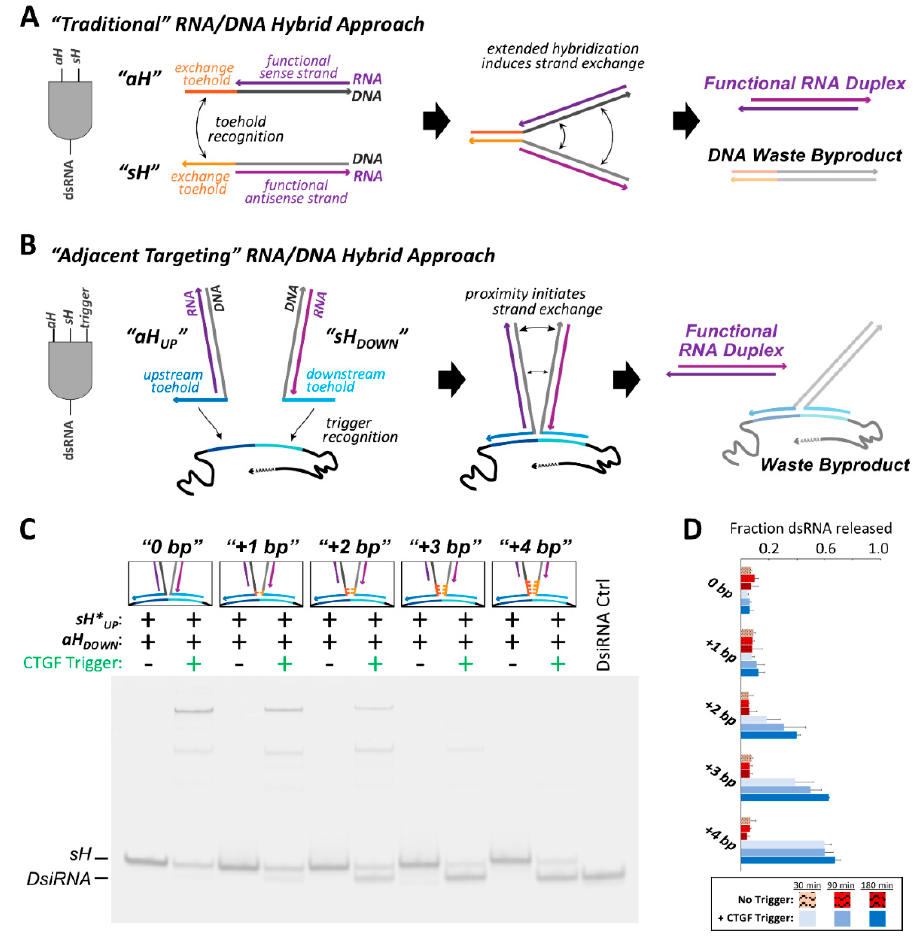
Figure 2. An RNA/DNA cognate pair system was designed to undergo conditional strand exchange by hybridizing to neighboring sites on an RNA trigger. ( A ) “Traditional” RNA/DNA hybrid pairs act as an 2-input AND gate. Hybridization between the single stranded toeholds of a sense hybrid ( sH ) and antisense hybrid ( aH ) initiates a thermodynamically driven strand exchange that generates a dsRNA duplex and DNA waste byproduct. ( B ) The “adjacent targeting” RNA/DNA hybrid system functions as a 3-input AND gate, requiring a hybrid pair as well as a specific RNA trigger sequence. The hybrid pair’s respective toeholds bind to regions of the trigger that are immediately upstream and downstream from one another. Anchoring the cognate hybrids in close proximity leads to initiation of the thermodynamically favorable strand exchange reaction and dsRNA release. ( C ) Five different cognate pairs of adjacent targeting hybrids were analyzed by 12% acrylamide non-denaturing PAGE for their ability to release a DsiRNA product. Each sense hybrid and the DsiRNA control assembly contained a 3 ′ 6-carboxyfluorescein (6-FAM) labeled sense RNA strand for visualization. The pairs of constructs differ in the number of DNA nucleotides inserted between the single-strand toehold and the RNA/DNA hybrid duplex. These inserted nucleotides were complementary between cognate hybrids, resulting in either 0, +1, +2, +3 or +4 DNA bp that can seed the strand exchange (colored orange). The presence or absence of each component is indicated above each lane. The samples in the gel depicted were all incubated for 180 min at 37 °C. ( D ) Analysis of the fraction of dsRNA released by hybrid pairs in the presence and absence of the RNA trigger following 30, 90 or 180 min incubations at 37 °C. Error bars indicate standard deviation of three replicate experiments. Indication of statistical significance between samples is reported in the supporting information.